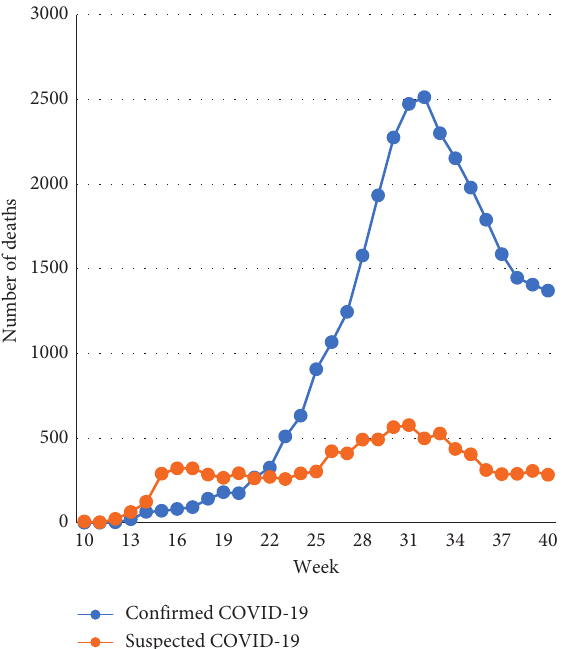
Figure 4: Weekly deaths from confirmed and suspected COVID- 19 according to DANE [36, 37] (the time horizon between March 2 and October 10,